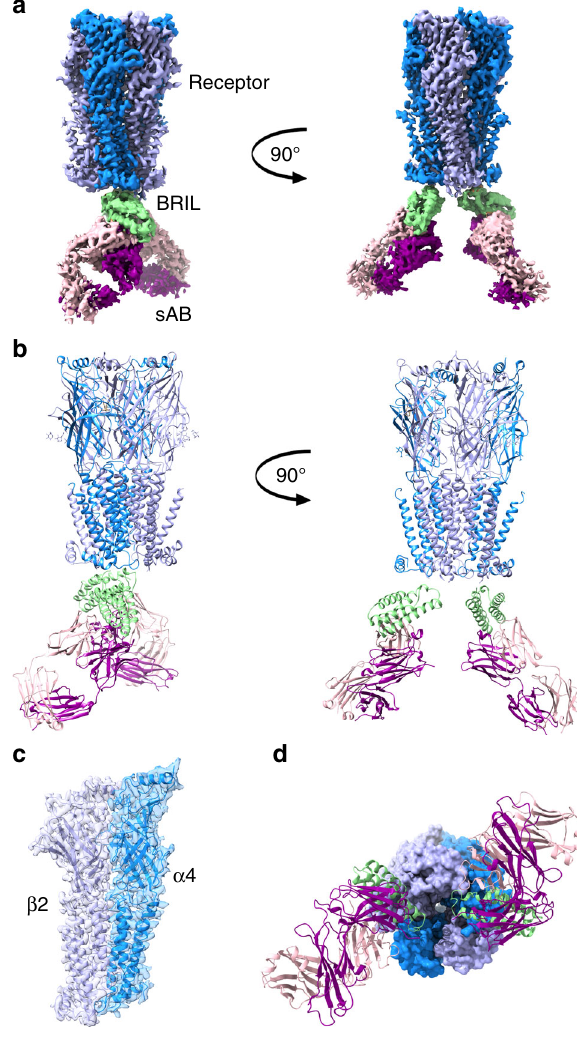
Fig. 6 CryoEM structure of the human α 4(BRIL) β 2 nicotinic acetylcholine receptor bound to sAB BAK5. a EM density map of the entire complex. b Cartoon representation of the receptor fused to BRIL in complex with the sAB. c Well de fi ned electron density map of the α 4 and the β 2 subunits of the receptor at the interface. d Bottom-up view of the complex. In all the panels, the α 4 and the β 2 subunits of the receptor are colored marine and light blue, respectively, BRIL is colored green, the light chain (LC) and heavy chain (HC) of the sAB is colored light pink and magenta,